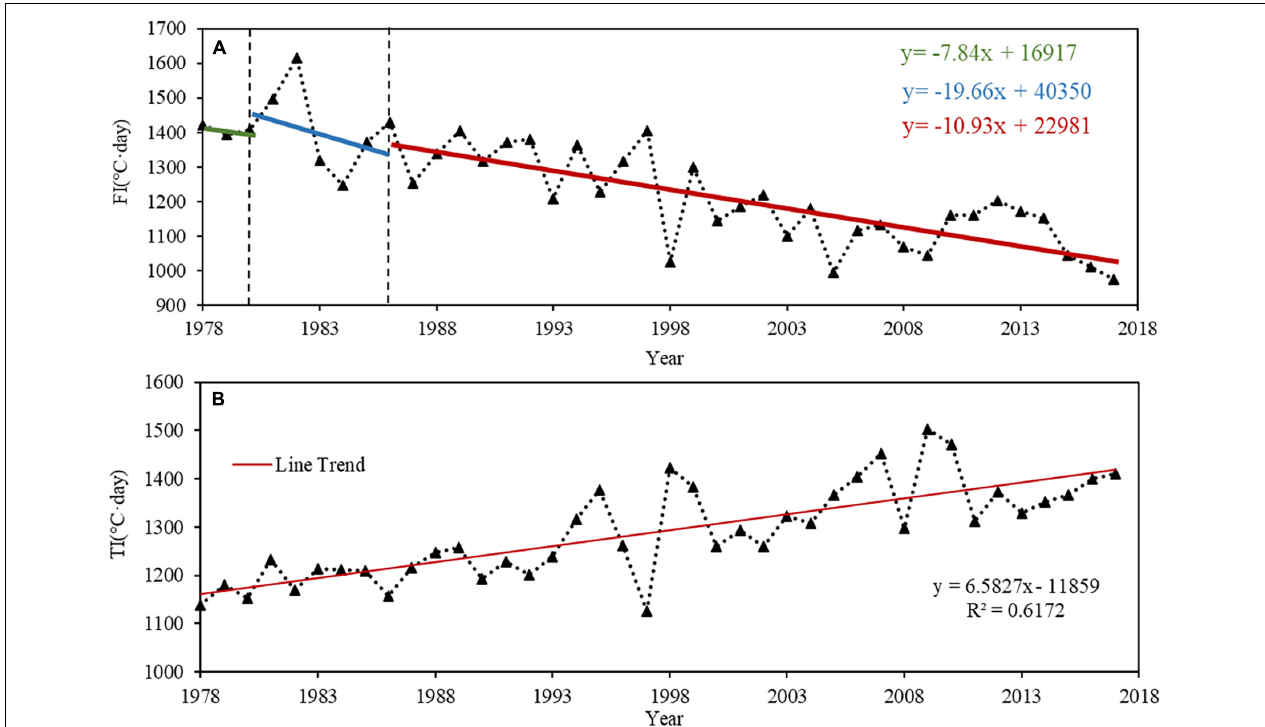
FIGURE 3 | (A) The 1978–2017 time series of FI and (B) TI; over Tibet. Green, blue and red line represents variation trend. Note that x is year and y is FI or TI. Vertical lines represent change